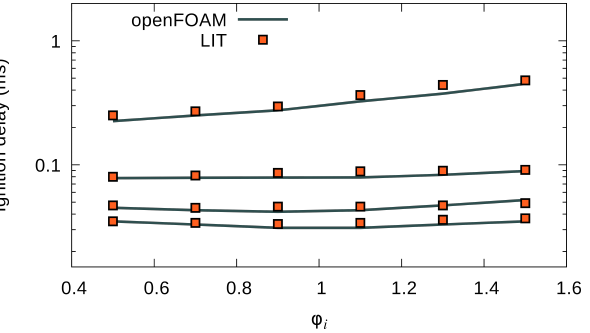
Figure 7. Ignition delay of H 2 –O 2 combustion as a function of ϕ for different T i = 1000–1150